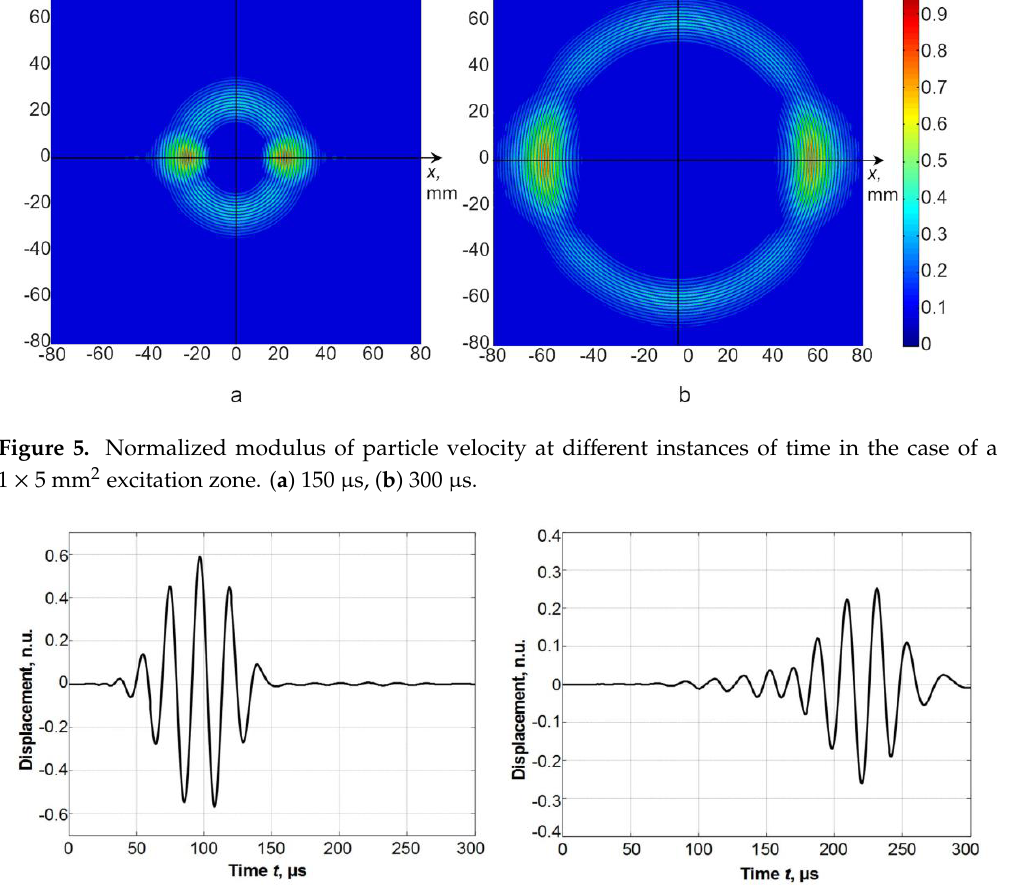
Figure 6. A-scans along the x axis at different distances from the excitation zone. ( a ) At a distance of 10 mm, ( b ) at a distance of 45 mm.